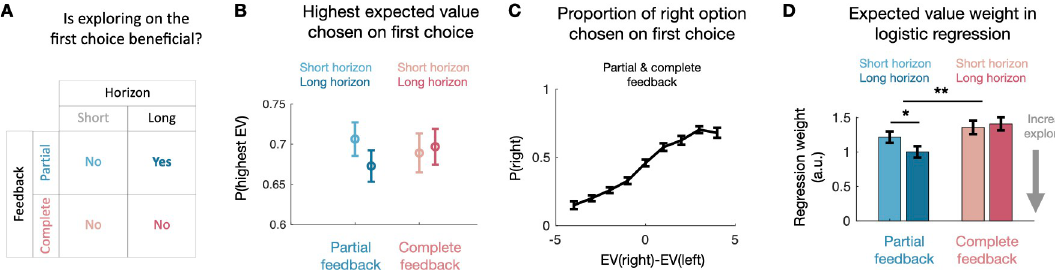
Fig 2. First choice. ( A ) In our experimental design, on the first choice of a horizon, directed exploration is only sensible in long horizon trials in the partial feedback condition. This is because in short horizon trials, the information gained by exploring is of no use for subsequent choices, so a rational decision-maker would only choose based on the expected value of the options. Moreover, in the complete feedback condition, all information is obtained regardless of which option is chosen, so an ideal observer would again always choose the option with the highest expected value. ( B ) The proportion of trials in which the monkeys chose the option with the higher expected value is above chance level (0.5) across both feedback conditions and horizons. Mean across sessions (partial feedback: 41 sessions, complete feedback: 40 sessions). ( C ) Monkeys’ choices are sensitive to nuanced differences in expected value. Mean across all sessions (81 sessions). ( D ) According to the logistic regression model predicting monkeys’ first choices in a horizon (see main text and methods for details), monkeys’ first choices are less driven by expected value in the partial than in the complete feedback condition. Within the partial feedback condition, they are less driven by expected value in long than in short horizon trials. No such difference was found in the complete feedback condition. This is evidence that monkeys deliberately modulate their exploration behavior to explore more on partial feedback long horizon trials, where exploration is sensible (see (A)). Error bars indicate standard error to the mean in B and C and standard deviation in D. Data and code to reproduce the figure can be found at